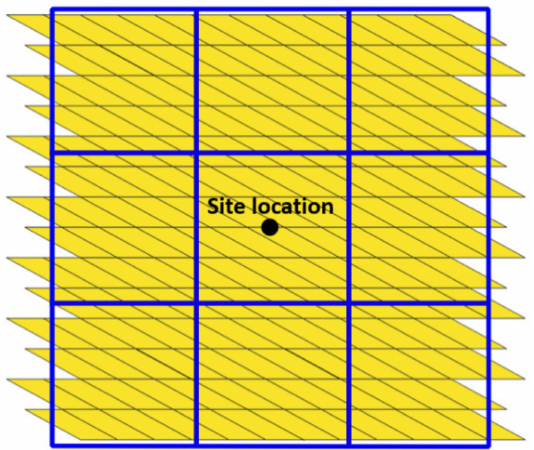
Figure 6. Example of the overlap and orientation of geostationary AHI 1 km pixel sampling area (3 × 3, blue gridded lines) with polar orbiting MODIS 250 m pixels (yellow area with black grid